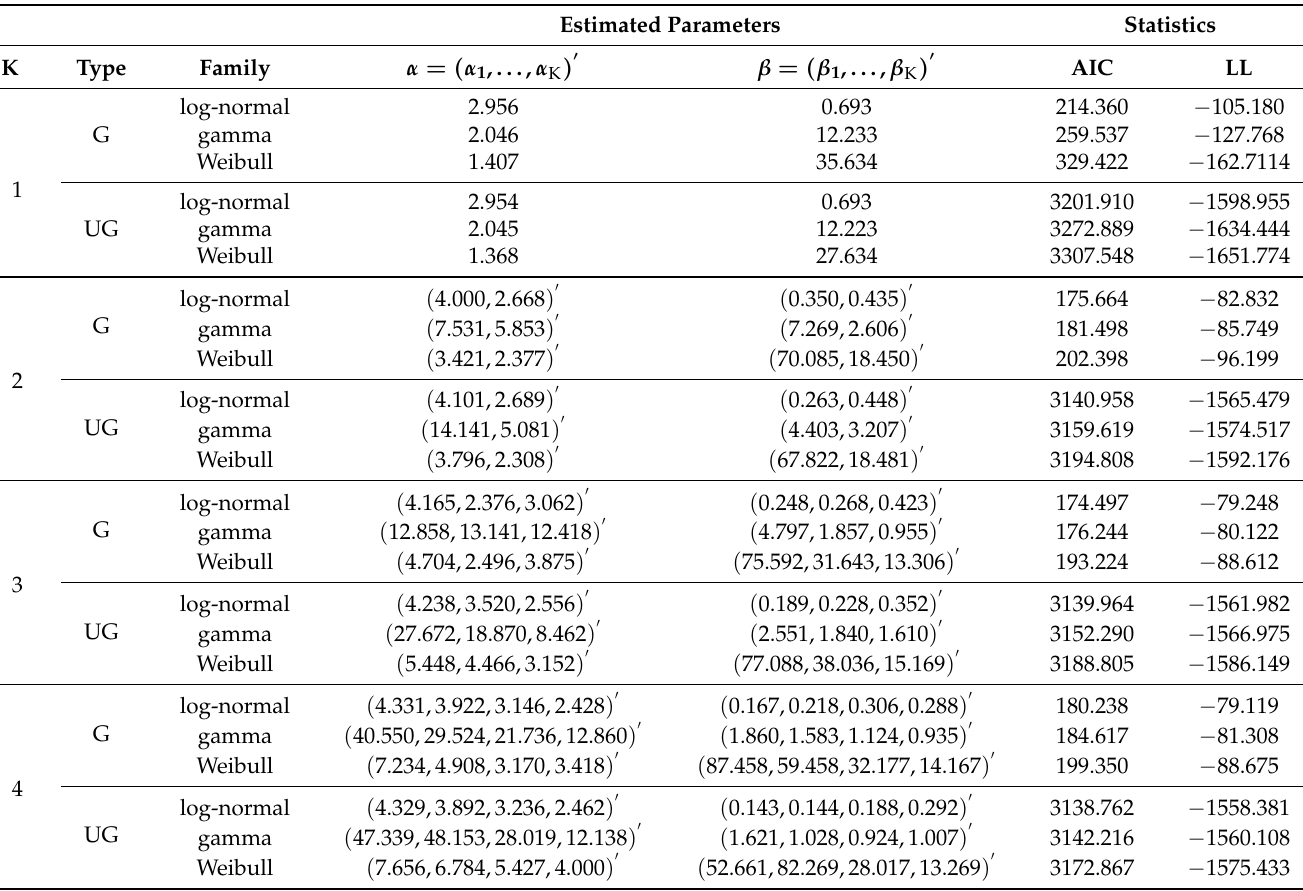
Table 3. Parameter estimates and goodness-of-fit statistics for the mixture of log-normal, gamma, and Weibull distributions fitted to sample 3 when DBH data are ungrouped (UG) and grouped (G) in classes of width 2.5 cm. It should be noted that the estimated vector of mixing parameters is not given for the sake of saving